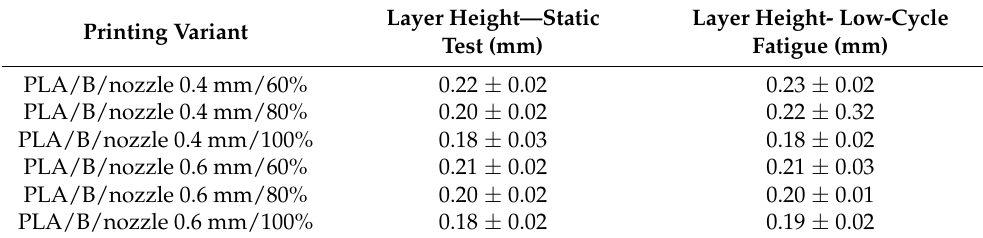
Table 4. Results of layer height measurements determined from SEM image